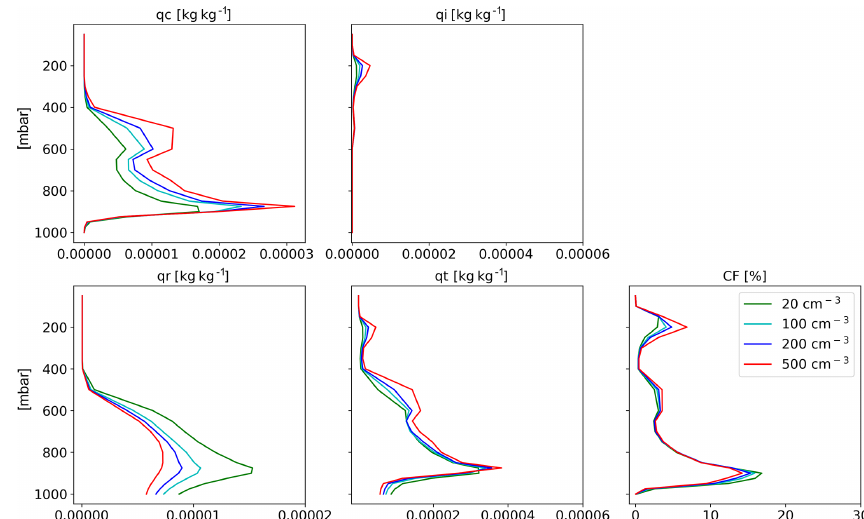
Figure 9. Domain- and time-average vertical profiles for the different CDNC simulations for the shallow-cloud-dominated case. The prop- erties that are presented here are cloud droplet mass mixing ratio (qc – for clouds’ drops with radius smaller than 40µm), ice mass mixing ratio (qi), rain mass mixing ratio (qr – for clouds’ drops with radius larger than 40µm), total water mass mixing ratio (qt = qc + qi + qr) and cloud fraction (CF). The x axis ranges are identical to the deep-cloud-dominated case – see Fig.